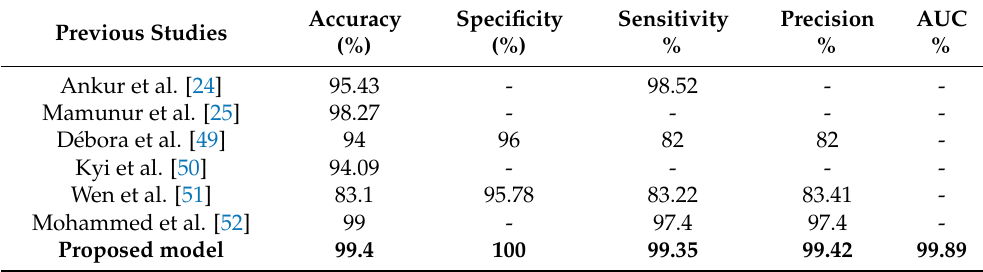
Table 7. Comparison of the results of the proposed system with the results of previous related